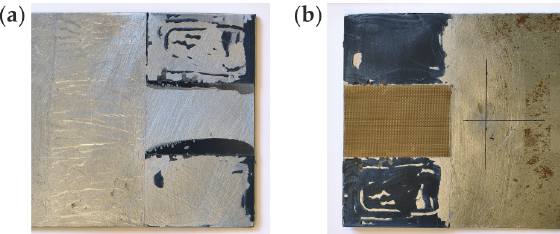
Figure 3. Photograph of experimental specimen after separation: ( a ) upper plate; ( b ) lower plate.